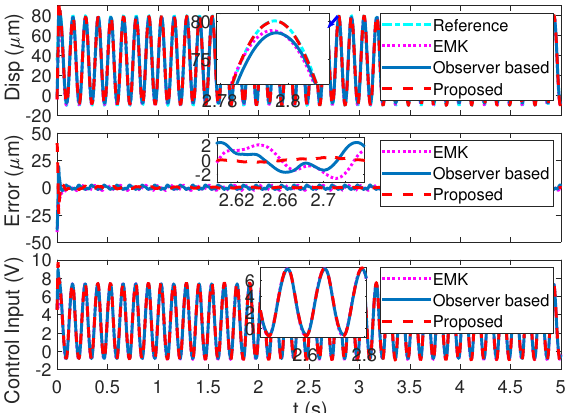
Figure 14. Experimental results of the three control methods (30 rad/s).